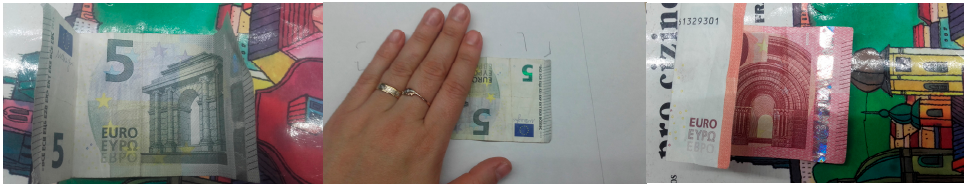
Figure 11. Crumpled and folded Euro banknotes: false recognition cases.